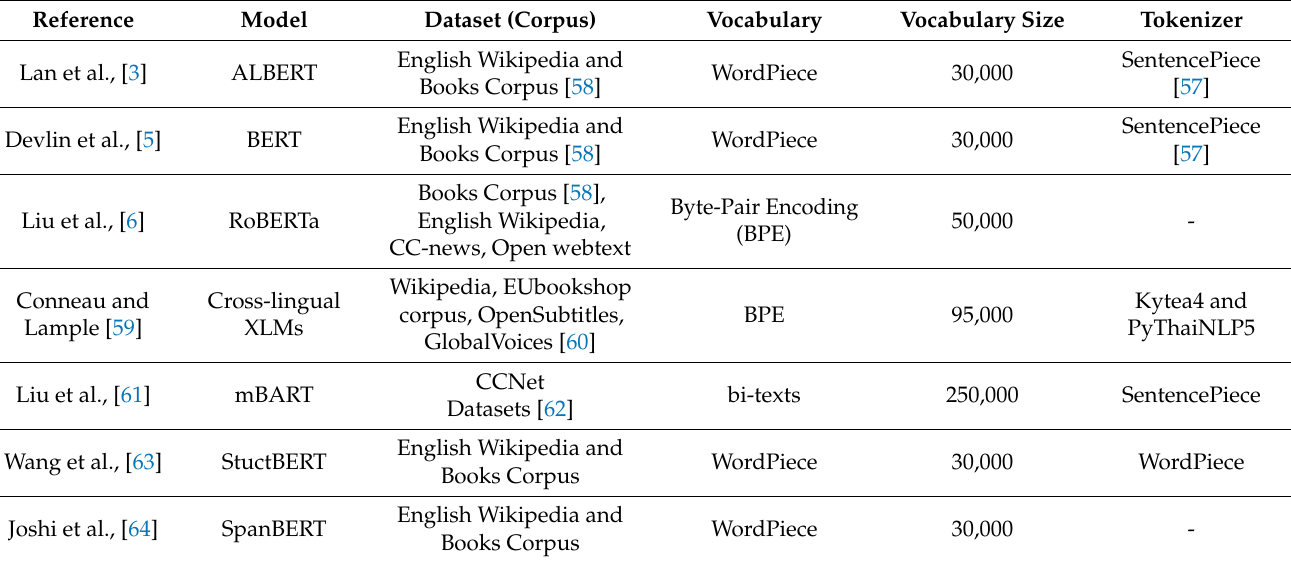
Table 2. Summary of dataset, type of vocabulary and tokenizer for pretrained